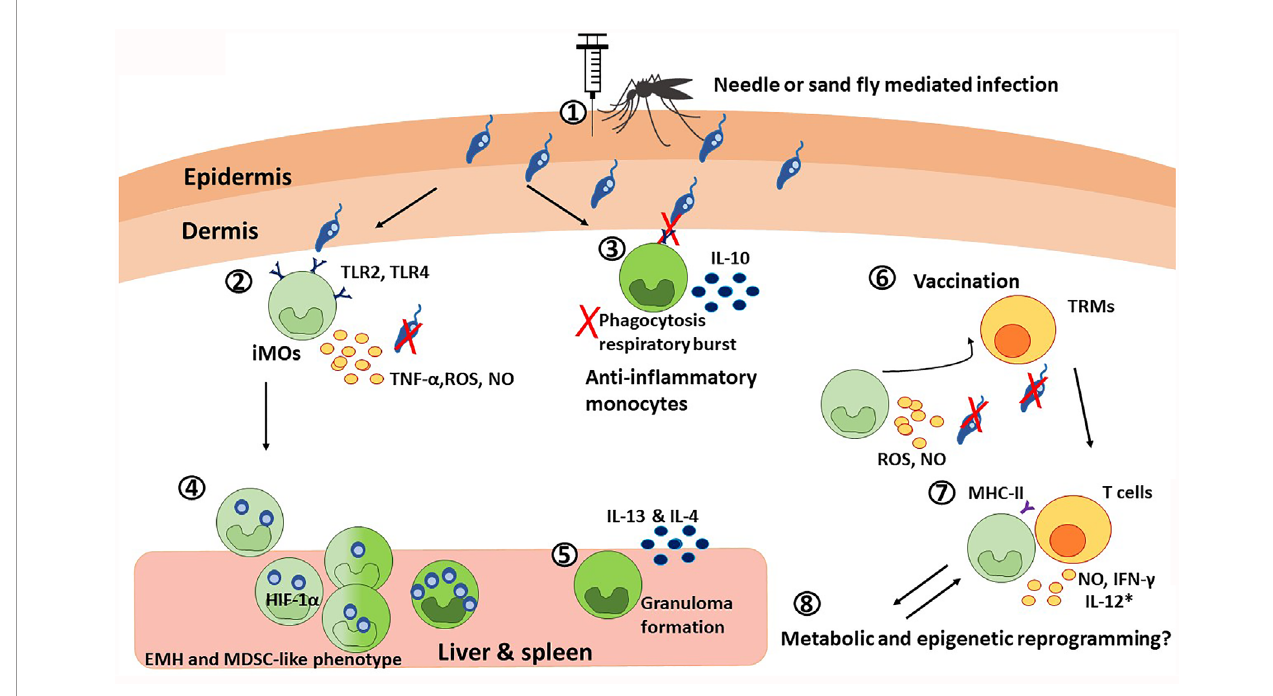
FIGURE 2 | The paradoxical roles of monocytes during visceral leishmaniasis. 1) Monocyte chemotaxis to the infection site is mediated in a CCR2-dependent manner. During the blood meal, this process is additionally potentiated by sand fl y salivary components. 2) The in fl ammatory monocytes, iMOs (light green), recognize Leishmania trough TLR2 and TLR4. TLR recognition, together with the IFN- g released by neutrophils, induce the secretion of TNF- a , ROS, and NO that results in parasite killing. Although the speci fi c cytokine regulation is species-speci fi c. 3) Particularly during VL, Leishmania can downregulate TLR2 and TLR4 signaling, dampening phagocytosis and respiratory burst, and promoting IL-10 production. This way, the parasite promotes its own survival by favoring the anti- in fl ammatory monocyte pro fi le (dark green). 4) Infected iMOs migrate rapidly to the liver and spleen, where they undergo extramedullary hematopoiesis (EMH) and acquire a HIF-1 a -mediated MDSC-like phenotype, that is permissive for parasite survival, as observed in VL patients. 5) In the liver and spleen, anti-in fl ammatory monocytes are necessary for granuloma formation via the production of IL-13 and IL-4, which has a protective role during VL. 6) In the context of vaccination, iMOs and T cells interplay is critical for memory responses. On the one hand, skin resident CD4+ memory T cells (TRMs) recruit iMOs to the infection site, where they produce ROS and NO to control the infection. 7) At the same time, iMOs activate T cell responses by presenting antigens via MHC-II and producing NO and IFN- g ; and with the use of co-adjuvants targeting monocytic response, iMOs can also produce IL-12 (*). 8) Finally, it is possible that monocytes undergo metabolic and epigenetic reprograming during